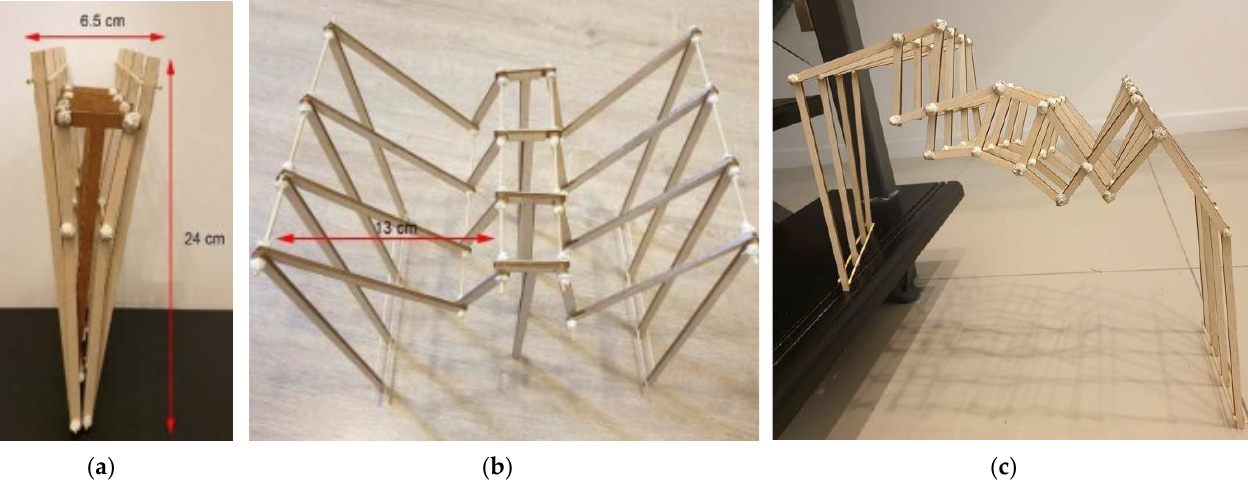
Figure 5. A prototype model based on a bat’s wing bone structure. ( a ) Double-span retracted posi- tion. ( b ) Double span (13 cm each side) with central support. ( c ) Single span up to 24 cm without central support. Photos: [26].